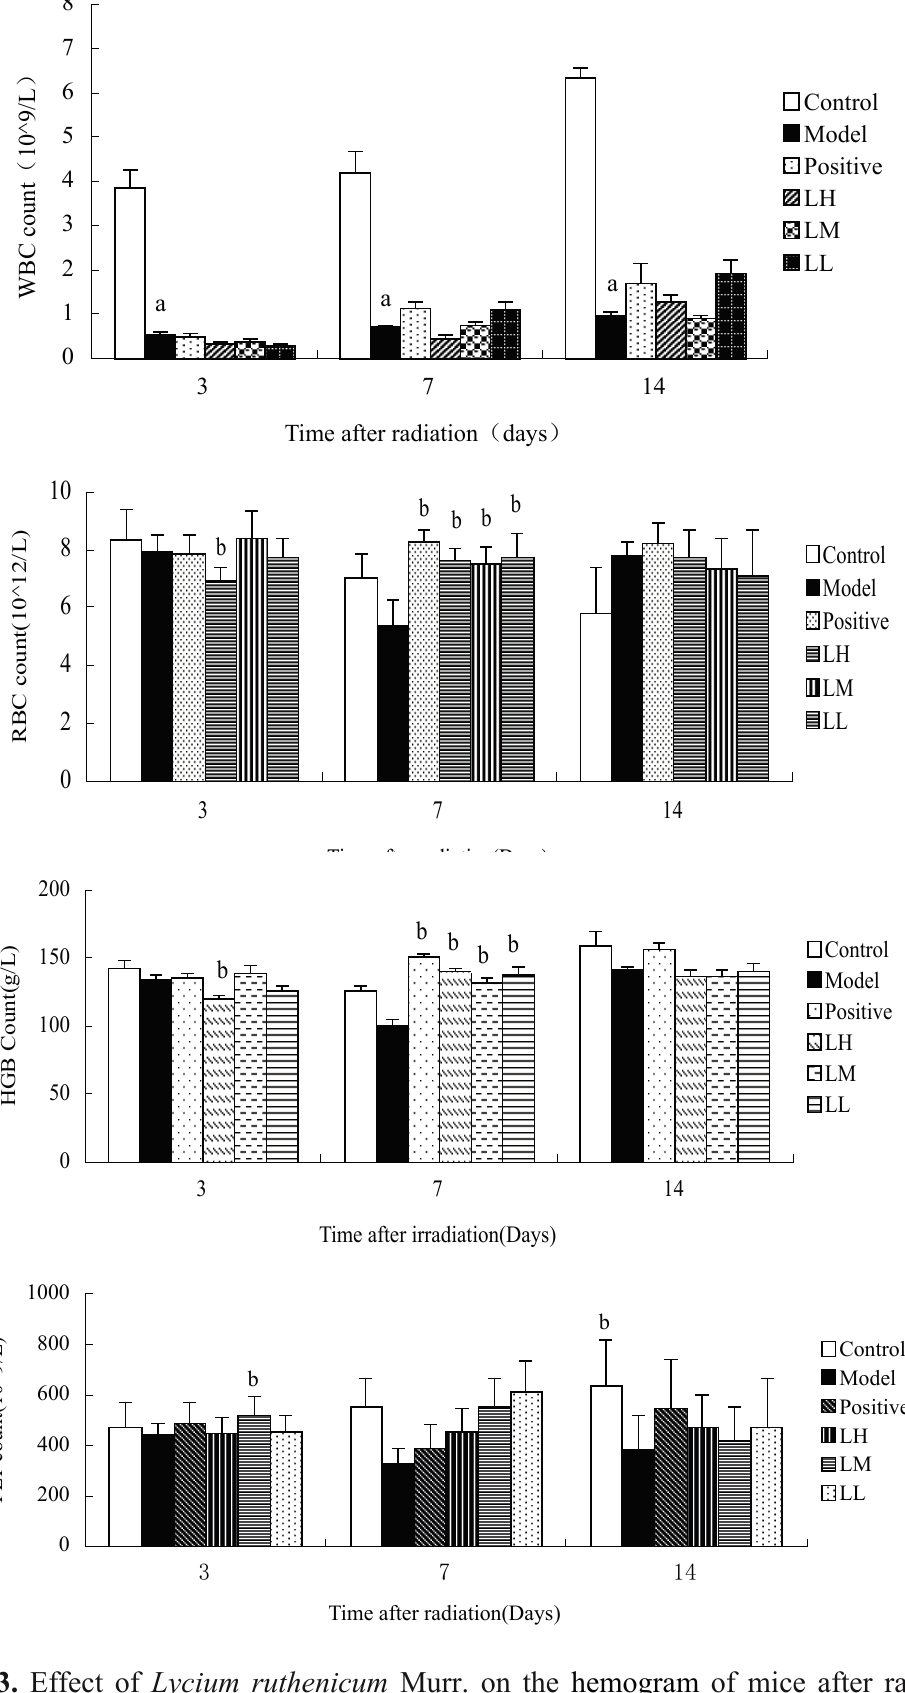
Figure 3. Effect of Lycium ruthenicum Murr. on the hemogram of mice after radiation. n = 10, mean ± SD. a p < 0.05 vs. control group, b p < 0.05 vs. model